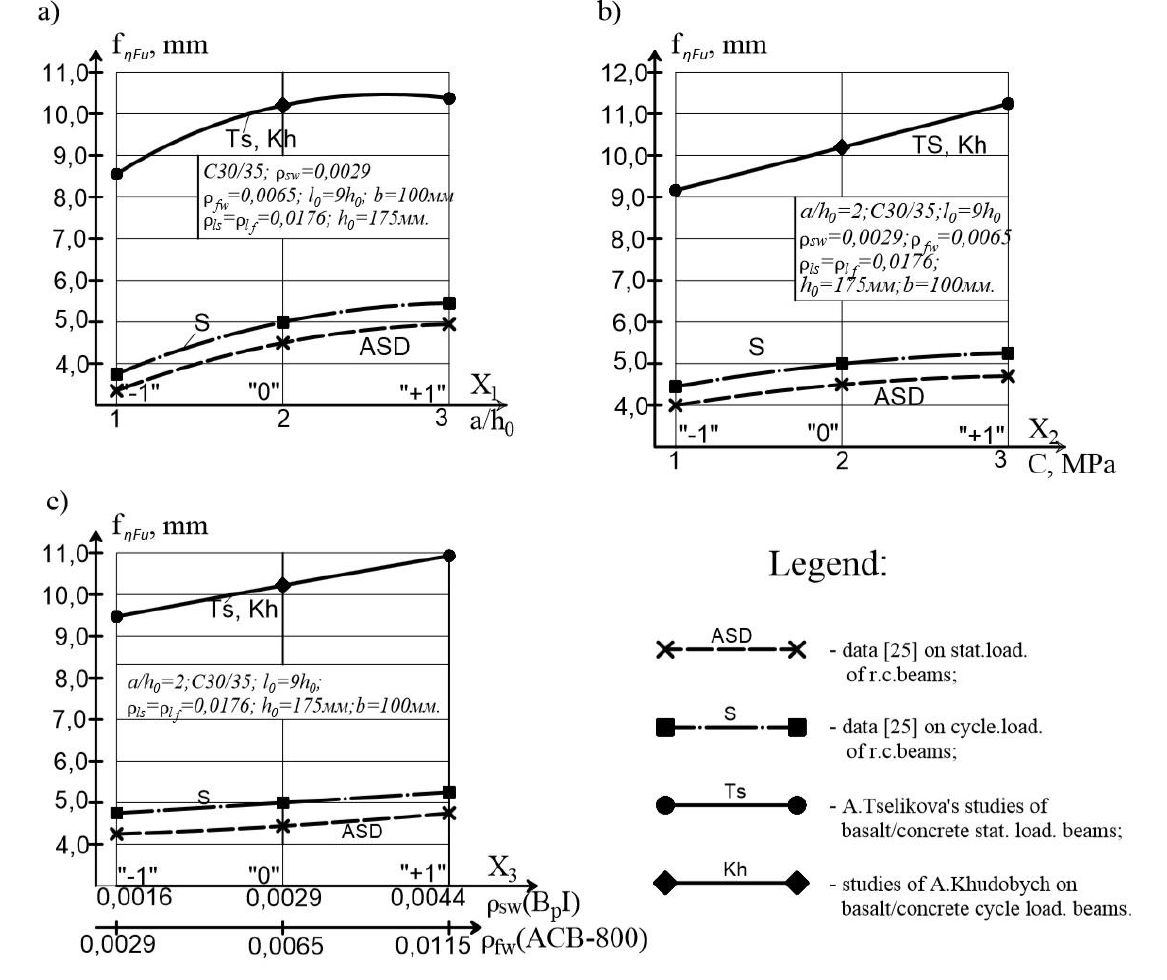
Figure 2. Beam deflections at the operational level of transverse loading versus the relativeshear span (а), concrete grade (b) and quantity of the transverse reinforcement